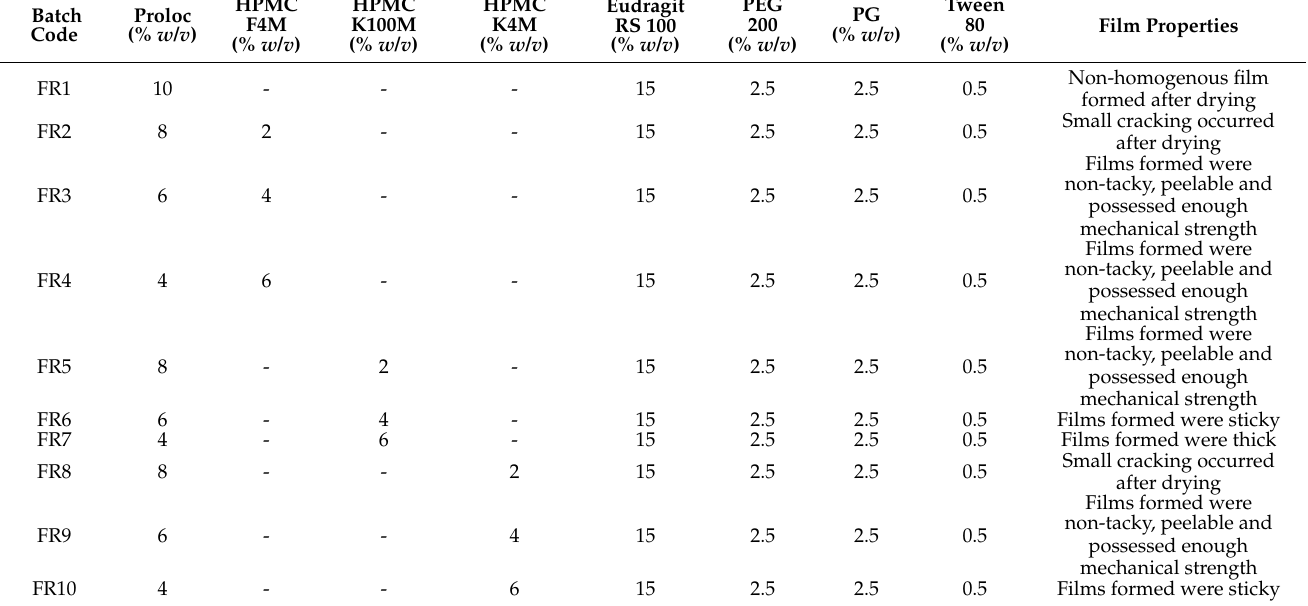
Table 1. Compositions used for preparing placebo films.